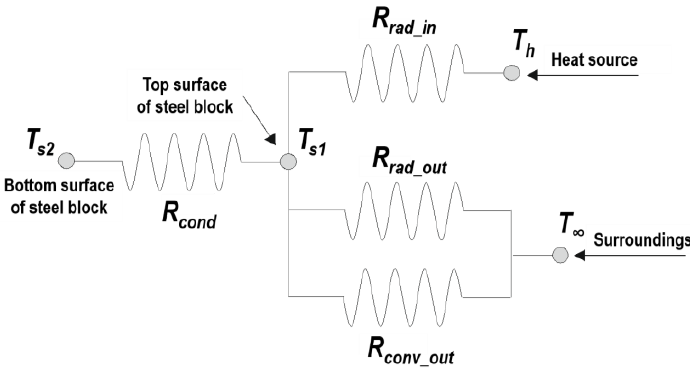
Figure 3. A diagram of thermal resistances in the heat transfer model using plain steel blocks.